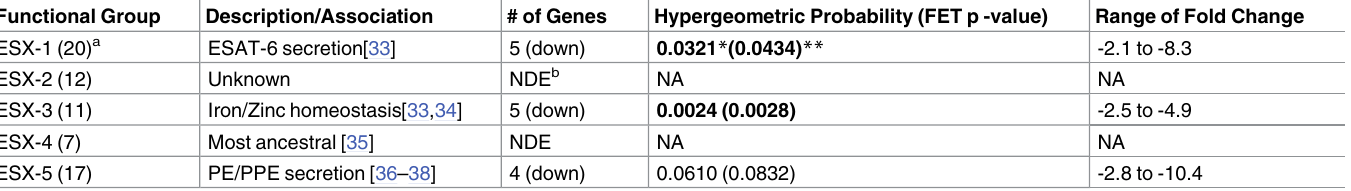
Table 6. Differentially expressedgenes located within ESX type VII secretion systemloci. Functional